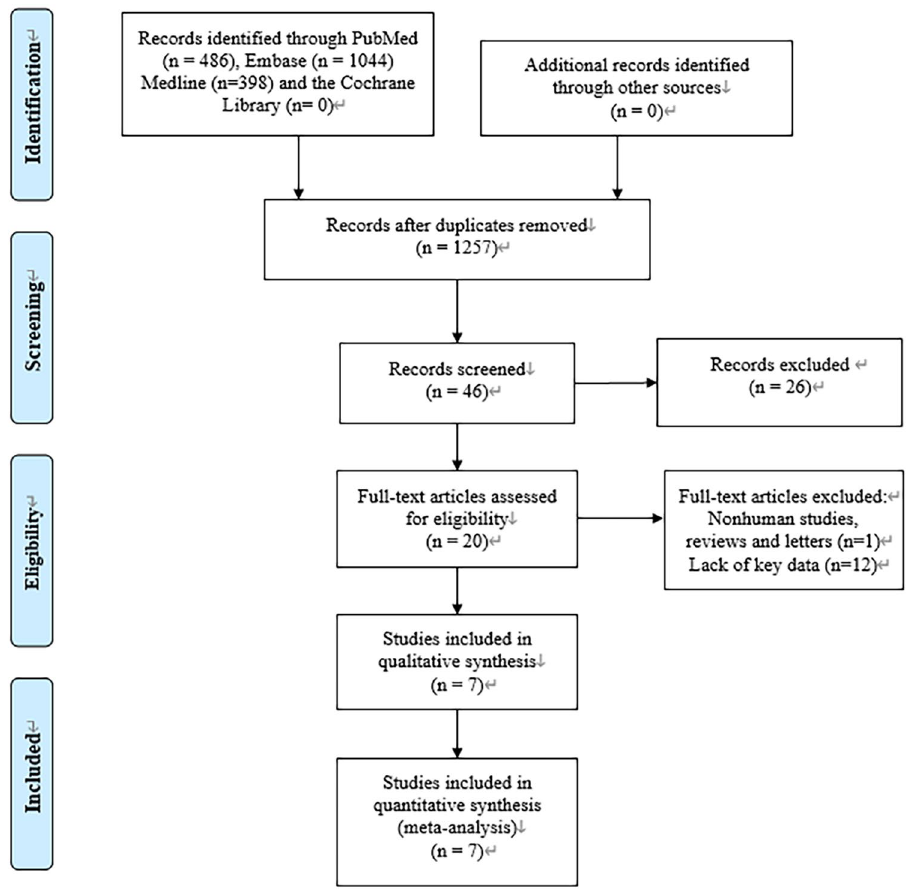
Figure 1. Flow diagram of this systematic review and meta-analysis.